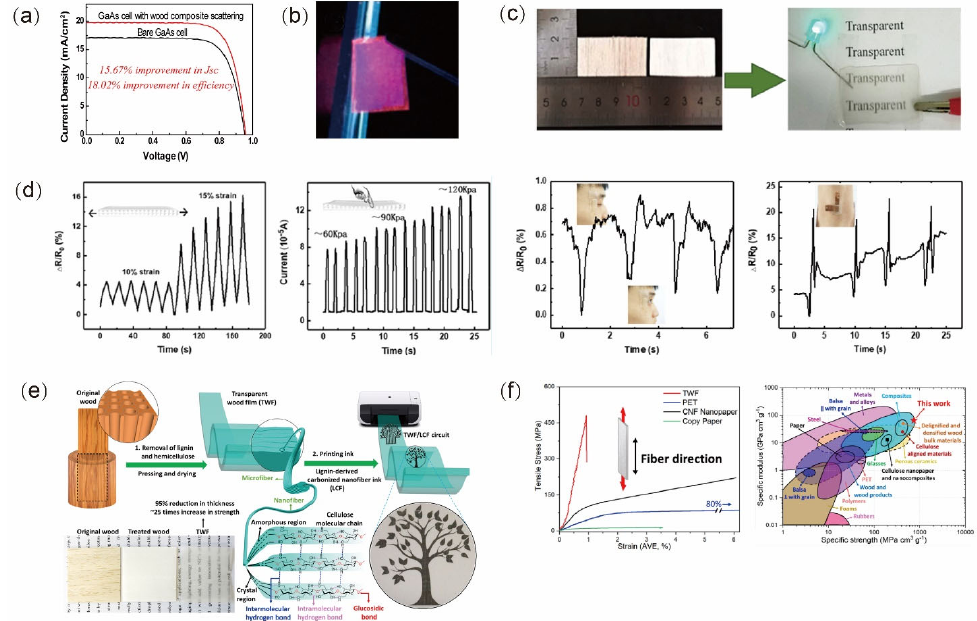
Figure 8. Application of TWC materials in optoelectronics: ( a ) current density versus voltage characteristics for a bare GaAs cell (black) and a GaAs cell with light management wood coating (red) [78]; ( b ) TW glowing under ultraviolet (UV) light [81]; ( c ) digital photograph of transparent conductive wood (TCW) with LED lighting [83]; ( d ) TCW used a strain/touch sensor to monitor human activities [83]; ( e ) processing of transparent wood film (TWF) for application in flexible electronics [84]; ( f ) mechanical properties of TWF compared with various other materials [84]. (( a ) Adapted from Zhu et al. [78]; ( b ) Adapted from Gan et al. [81]; ( c , f ) Adapted from Fu et al. [84]; ( d ) Adapted from Wang et al. [83]).